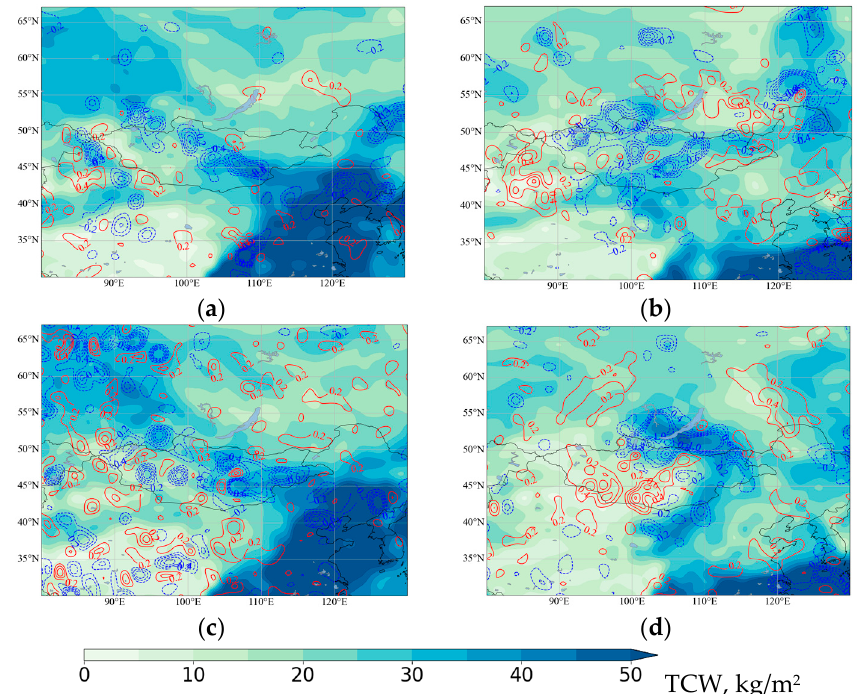
Figure 7. Total column water (filled) and vertical velocity at 500 hPa (red—descending motions, blue—ascending) for 1st case (1994) ( a ) 8th July 0 UTC, ( c ) 12 UTC; and 2nd case (2001) ( b ) 6th July 0 UTC, ( d ) 18 UTC .